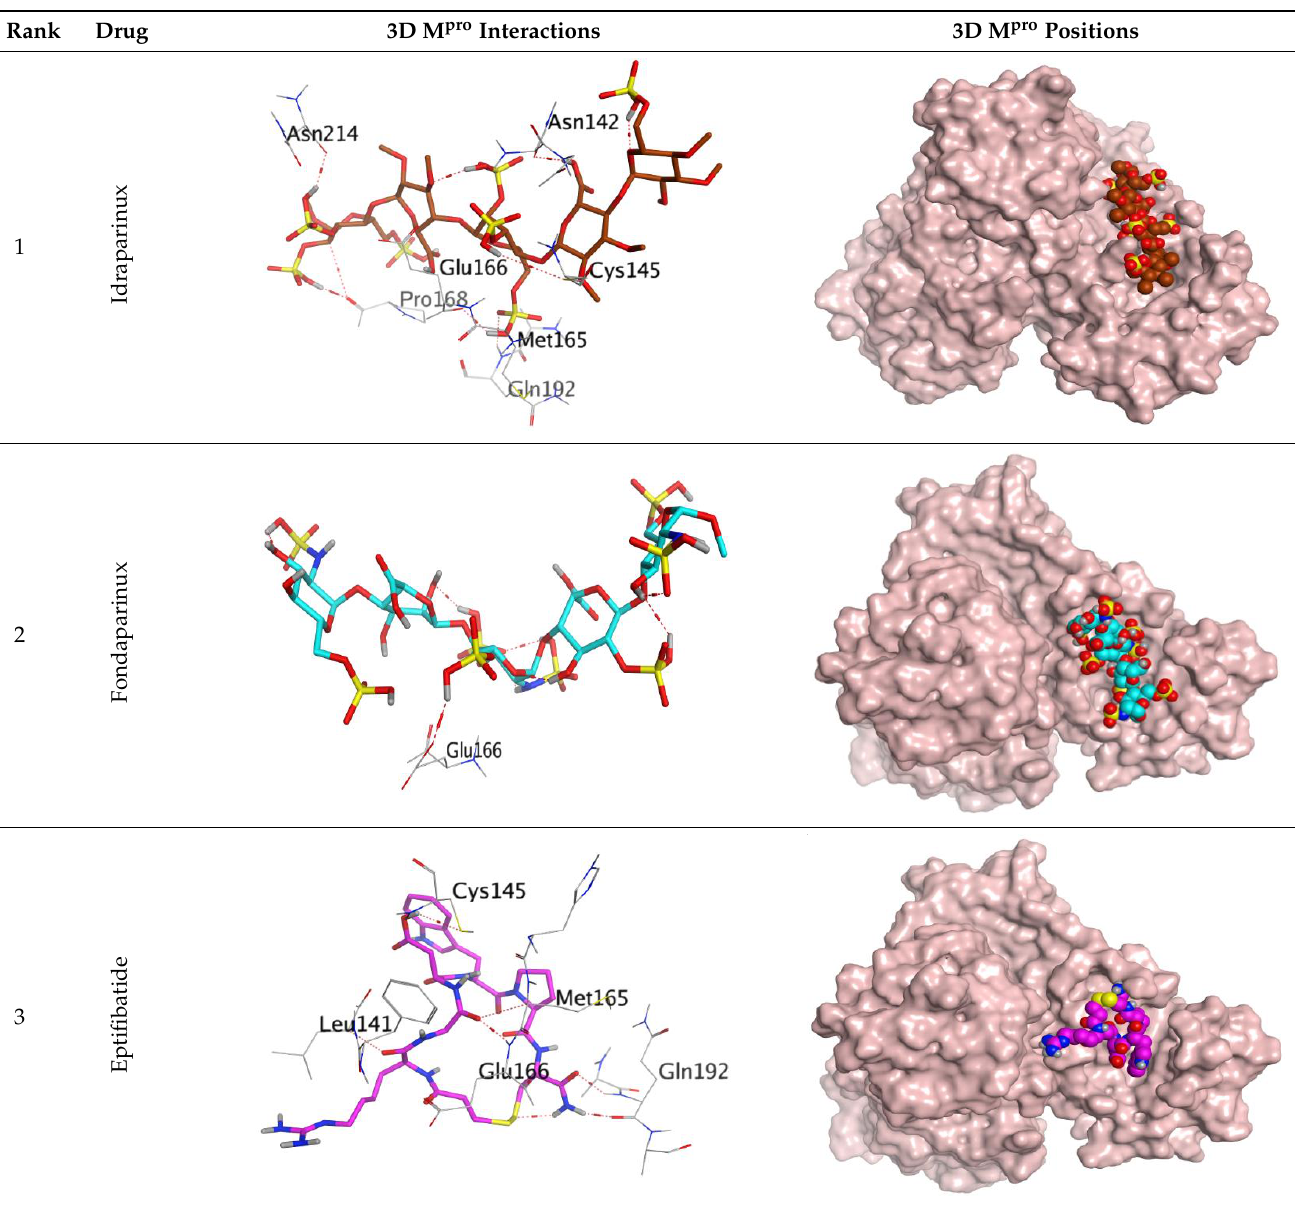
Table 1. Three-dimensional binding interactions and positions of idraparinux, fondaparinux, eptifi- batide, heparin, and ticagrelor compared to the O6K inhibitor within the binding site of SARS-CoV-2 M pro .